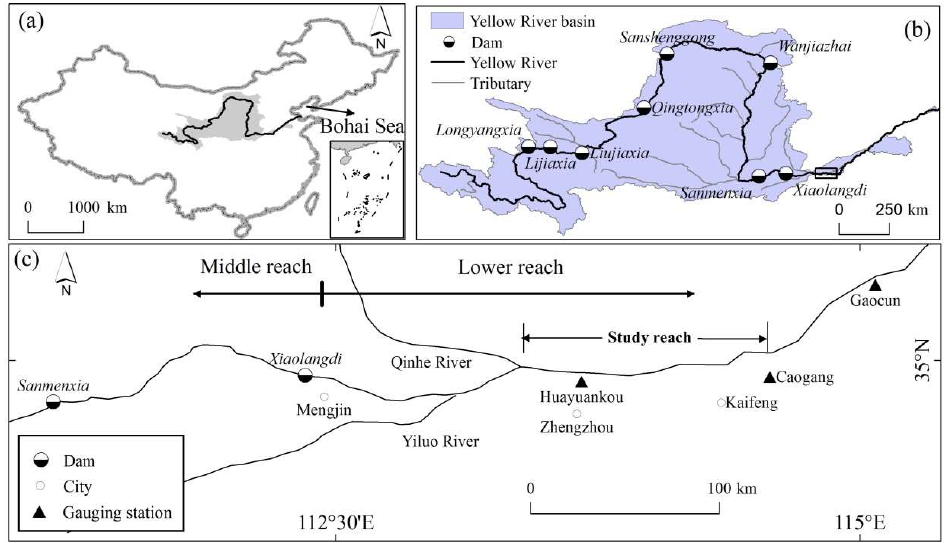
Figure 1. Location of the study area: ( a ) the entire drainage basin of the Yellow River; ( b ) Major dams and main tributaries of the Yellow River (the black rectangle is the area of this study); and ( c ) location of the study reach in the Lower Yellow River including major dams constructed on the river trunk, main tributaries, important places, and gauging stations.